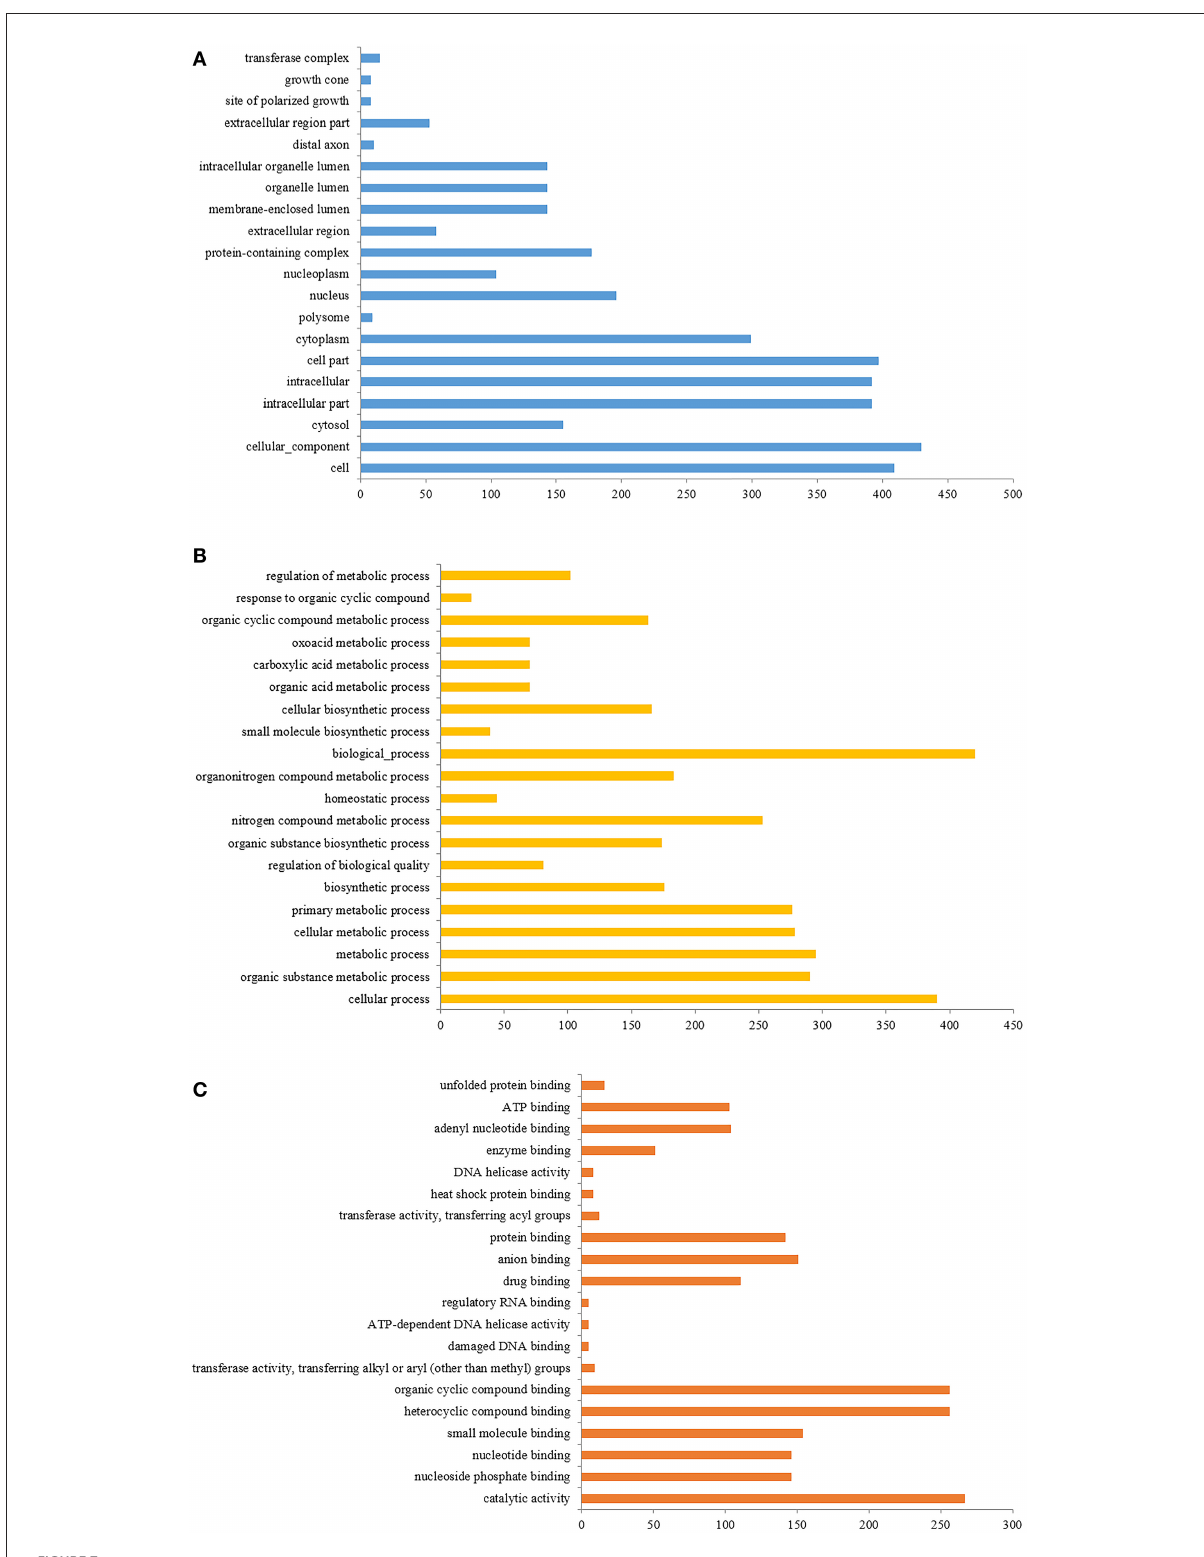
FIGURE7 (A) The GO enrichment analysis of differentially expressed proteins (cell components); (B) is the GO enrichment analysis of differentially expressed proteins (Biological Process); (C) is the GO enrichment analysis of differentially expressed proteins (Molecular